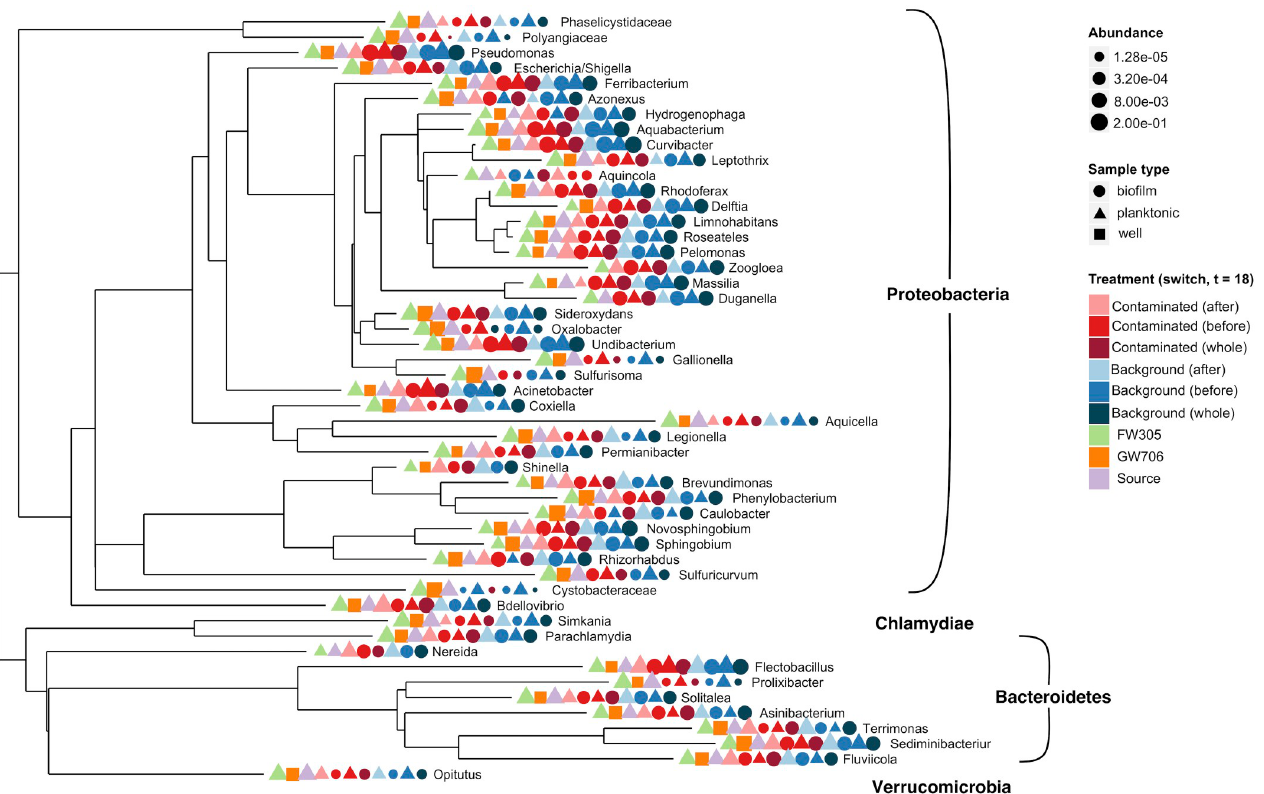
Fig 3. Phylogeny and relative abundance of top 50 (by abundance) 16S rRNA OTUs. OTUs have been merged at the genus level. Included in analyses are planktonic and biofilm communities from control (background, FW305 receiving) and contaminated (receiving GW706 water) reactors sampled before and after the switch from FW305 to GW706 water (day 18), and communities from FW305 and GW706 wells and the source reservoir